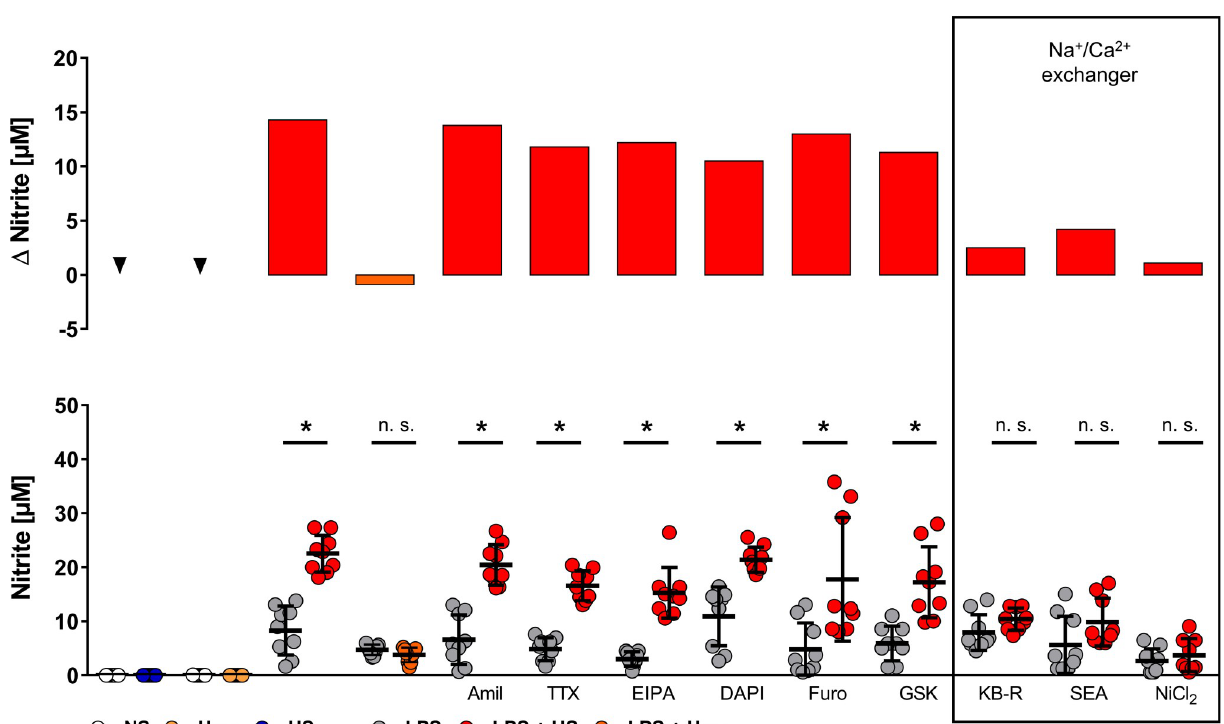
Fig 2. NCX inhibitors abrogate HS-boosted NO production of LPS-stimulated M F s. Lower panel: nitrite levels of RAW264.7 M F s pretreated with indicated inhibitors and stimulated ± LPS ± HS or 80 mM urea (mean ± SD; n = 9; Student t test or Mann–Whitney test; � p < 0.05). Upper panel: changes of means in nitrite production upon indicated stimulation and/or treatment ( Δ nitrite). For numerical raw data, please see S1 Data. HS, high salt; LPS, lipopolysaccharide; M F , monocyte/macrophage-like cell; NCX, Na + /Ca 2+ exchanger; NO, nitric oxide; NS, normal salt; n.s., not